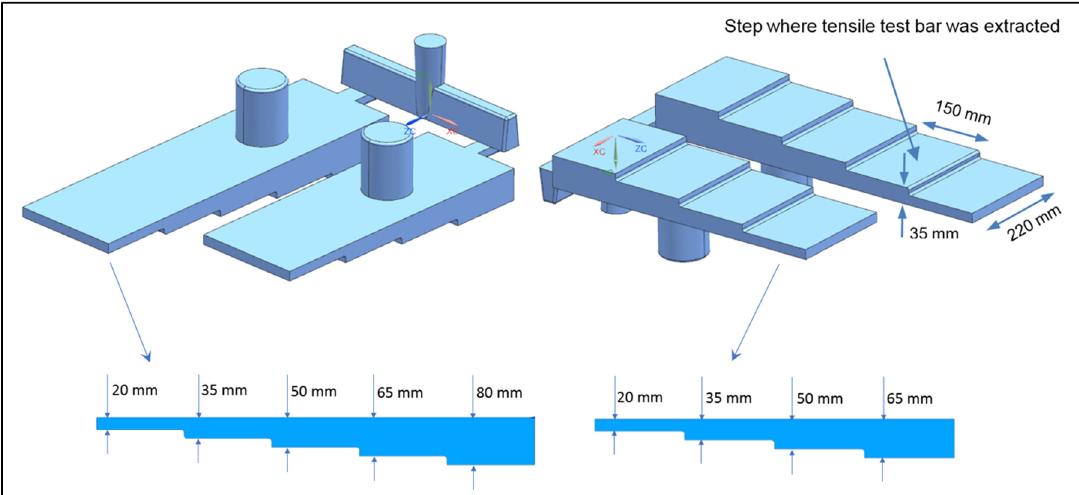
Figure 6. Top and bottom view of the part geometry.